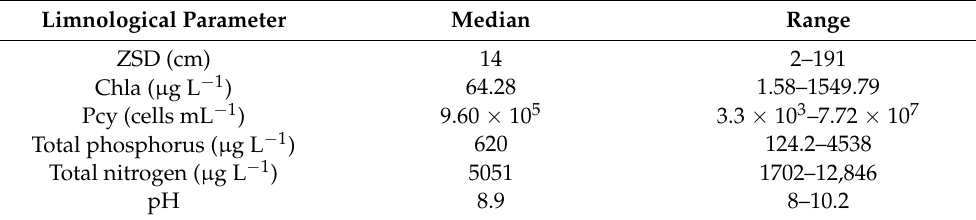
Table 1. Median and range of limnological variables corresponding to the “validation” dataset (i.e., 82 shallow Pampean lakes sampled during spring and summer surveys performed in 2009 and 2015). Limnological Parameter